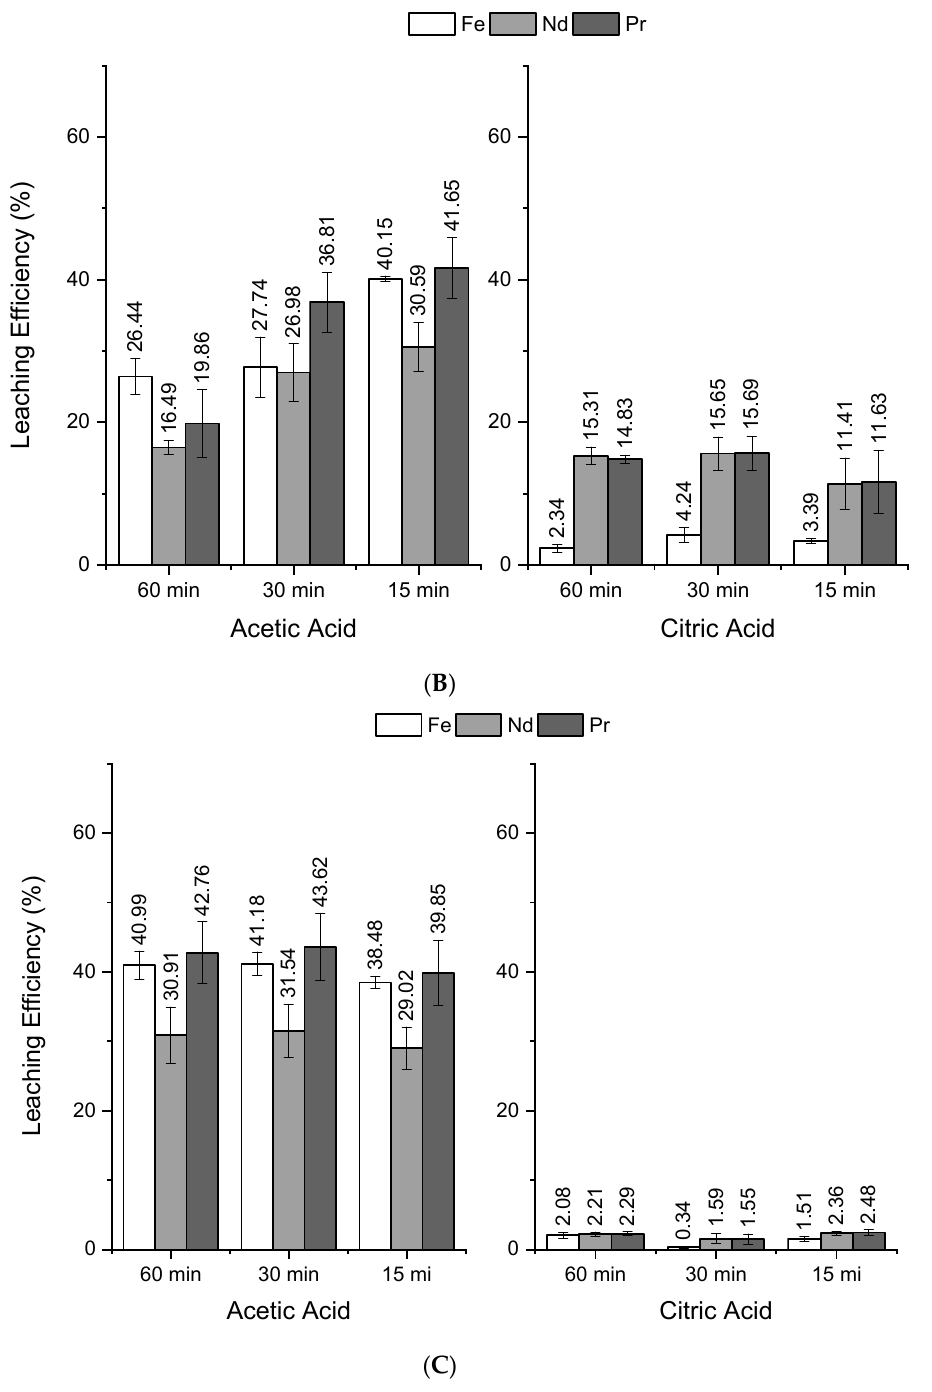
Figure 5. Comparison of the leaching efficiency of NdFeB magnets in acetic and citric acids, concen- tration 0.25 M, ratio s/l ( A ) 1/100; ( B ) 1/50 and ( C ) 1/10.